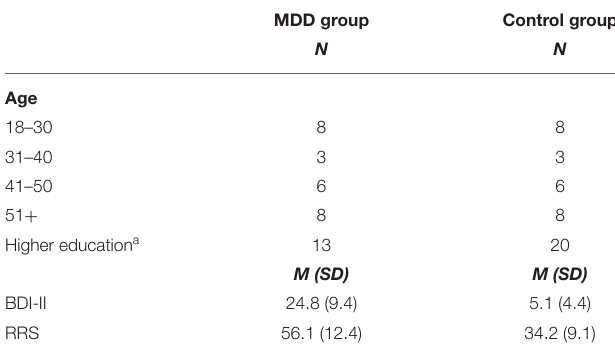
TABLE 1 | Participant characteristics study